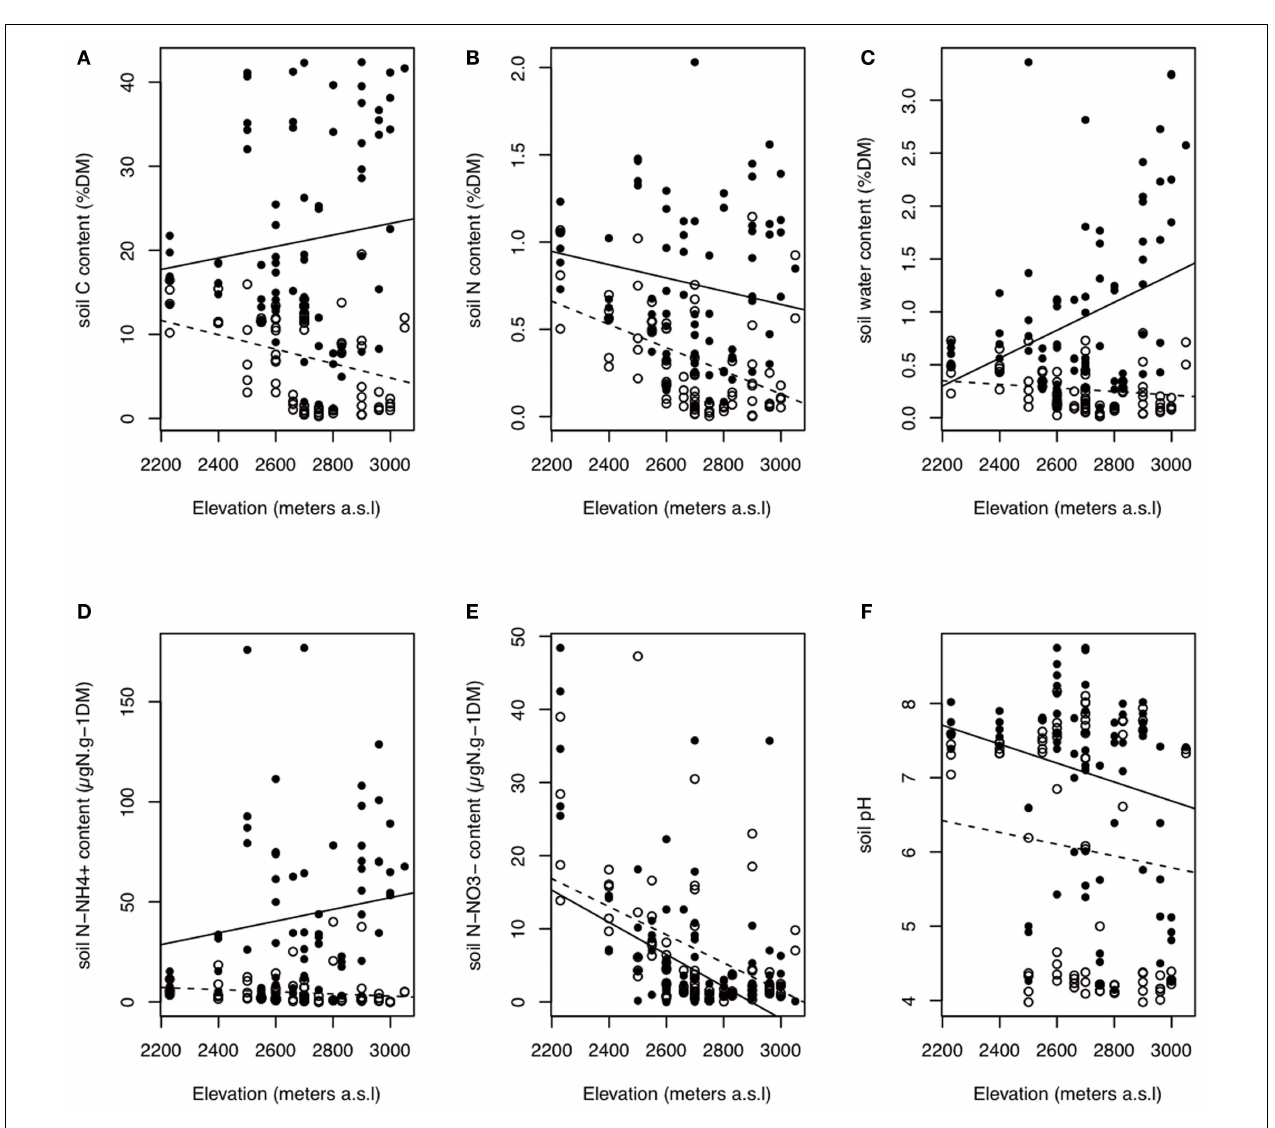
content, and soil pH, respectively. Elevation did not affect the soil pH ( TableA1 in Appendix).The observed trend between soil pH and elevation could come from the confounding effect of bedrock and elevation on pH because siliceous samples are, on average, higher in elevation. DM, dry